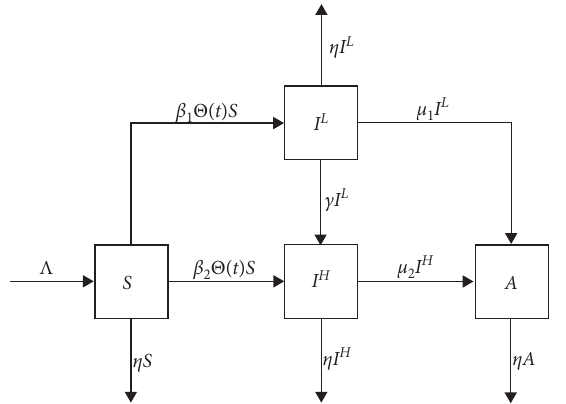
Figure 1: The flow diagram of the propagation